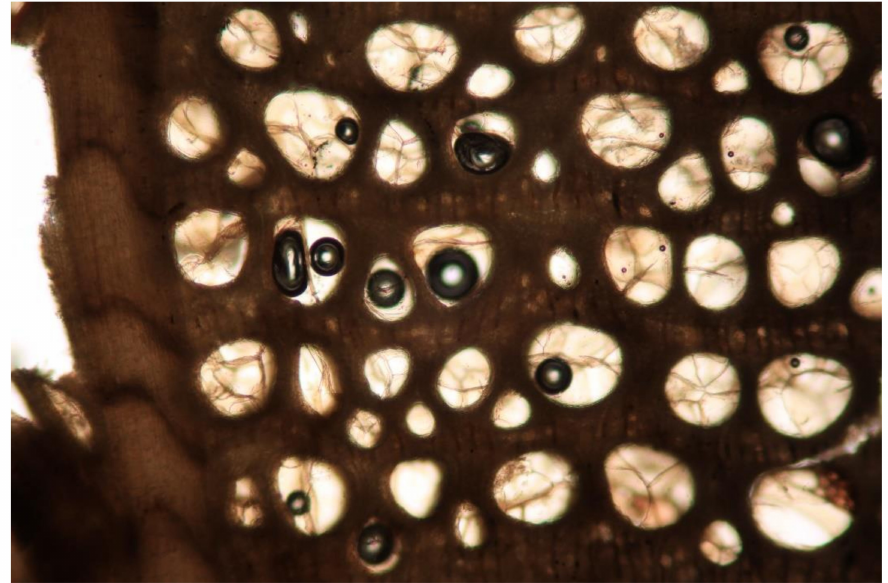
Figure 5. Light microscope image of a transverse section of a slow-grown Quercus spp. wood belonging to the White oak group (50 × ). Formation of tyloses in vessel members is prominent. The waterlogged wood sample derives from an underwater excavation site at the mouth of Ropotamo River located along the Bulgarian coast [34]. Image: A. Zisi, © Black Sea MAP.